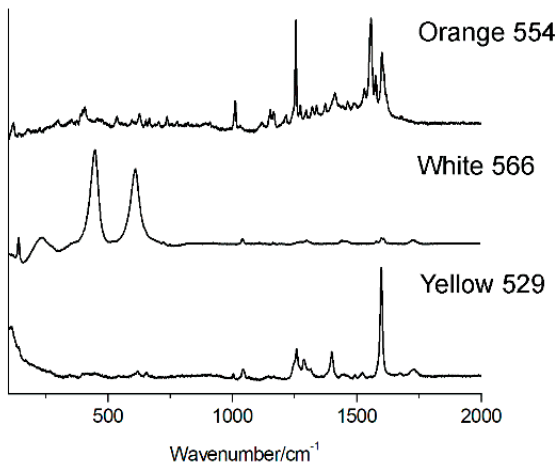
Figure 2. Raman spectra of the commercial sprays of the Titan brand.